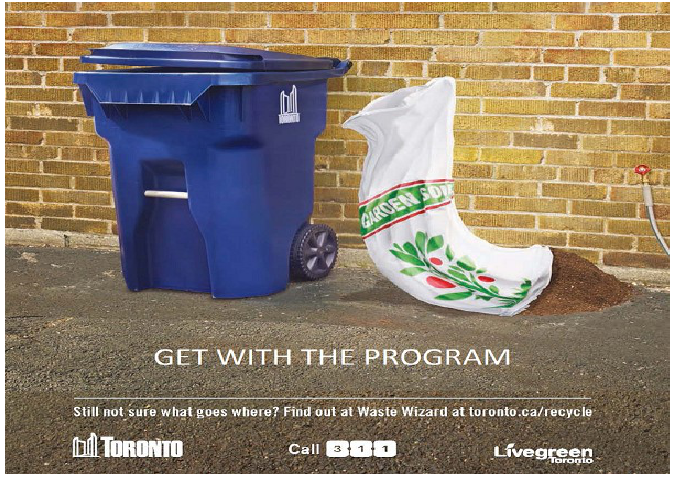
Figure 10. Sample Sign #2 Soc. Sci. 2016 , 5 , 23